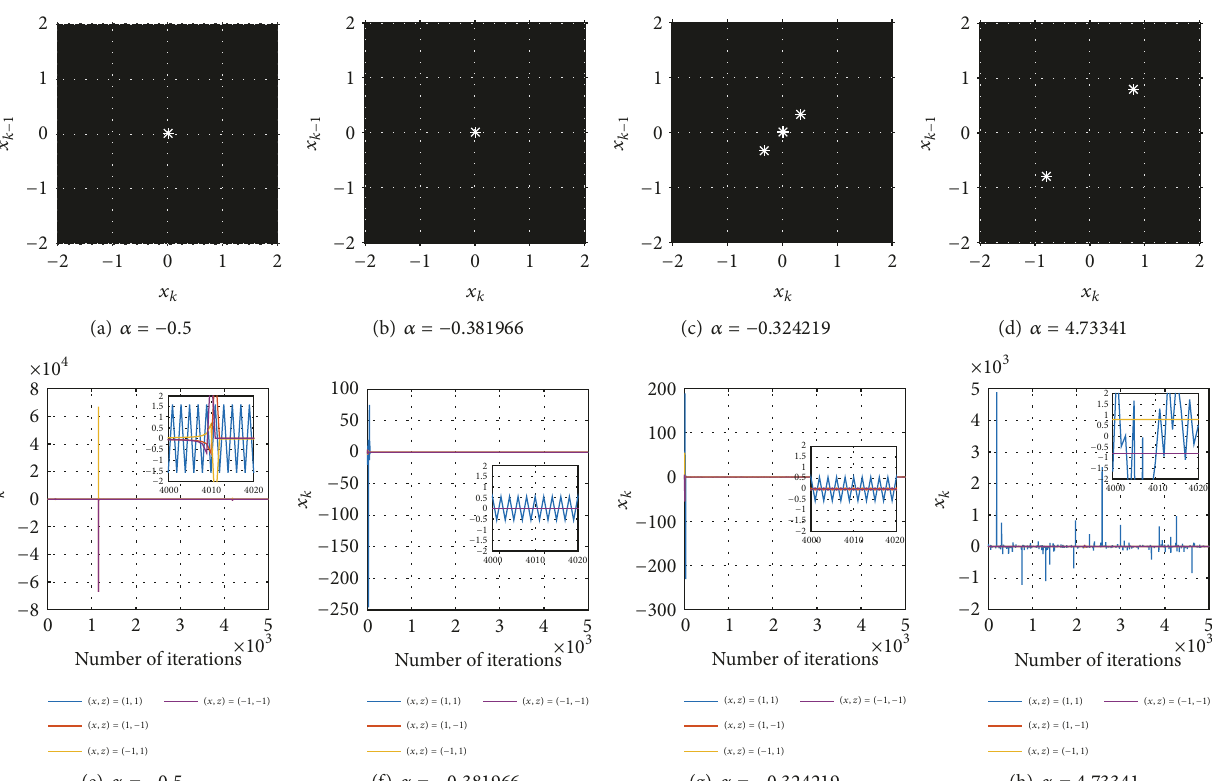
Figure 13: ((a)–(d)) Dynamical planes of method 𝑀 𝛼 (𝑧, 𝑥) for 𝑓(𝑥) = 𝑥 2 + 1 . ((e)–(h)) Orbit of points 𝑥 𝑘 for 5000 iterations; inset: orbit at iterations 4000 to